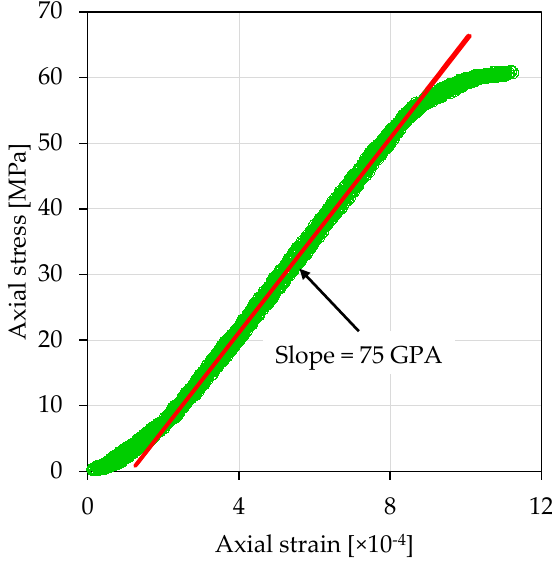
Figure 2. Stress–strain curve of the marble specimens under study.